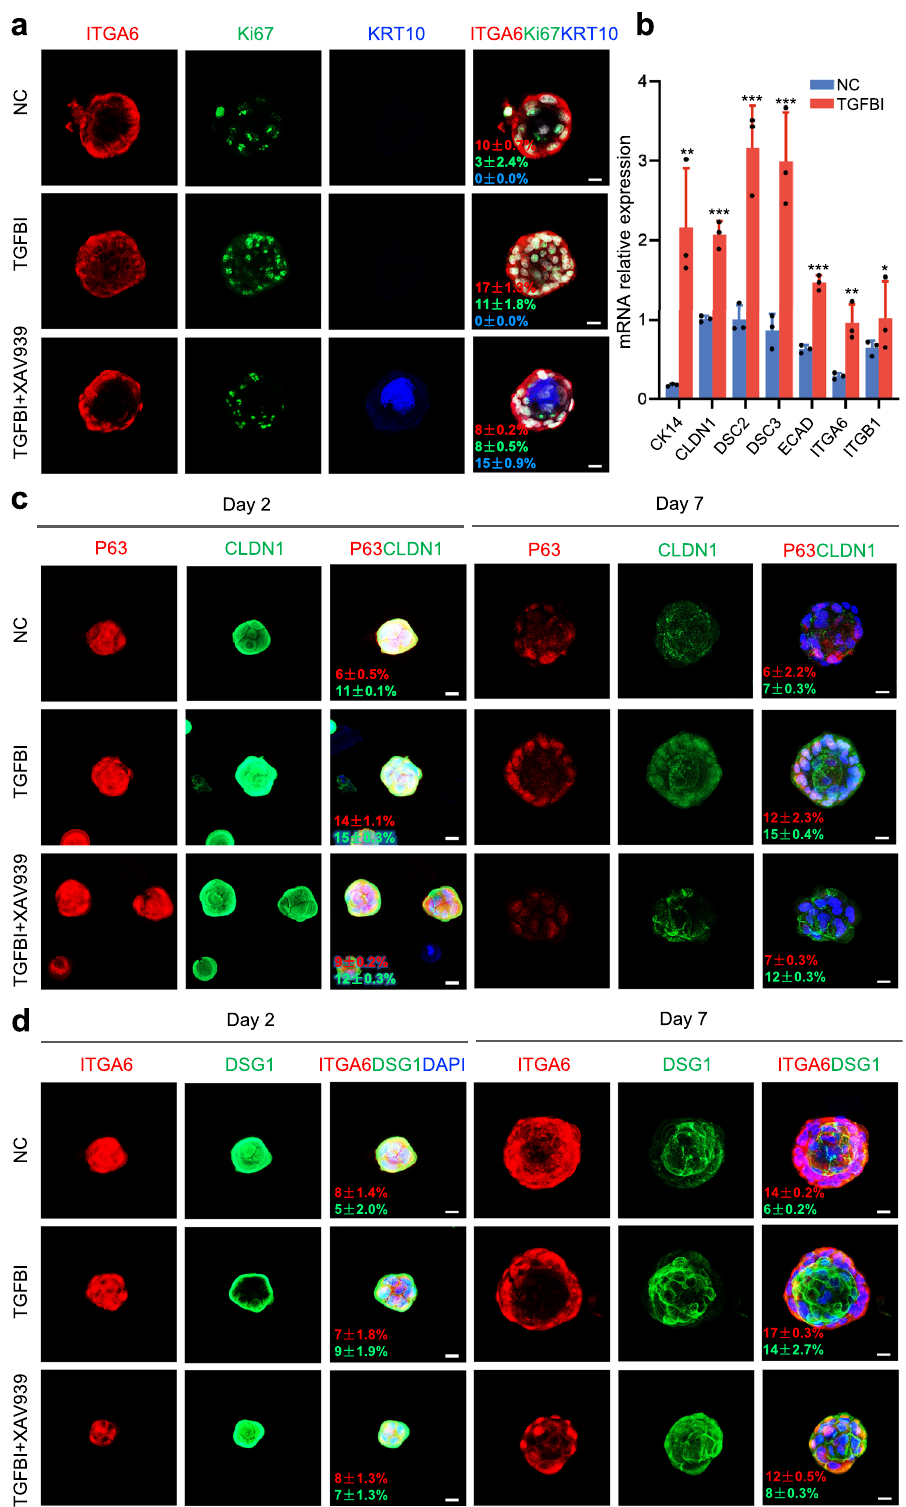
Fig. 5 TGFBI enhanced epidermal organoid development. a Immuno fl uorescence of ITGA6, Ki67, and KRT10 in epidermal organoids treated with TGFBI and XAV939 for seven days of culture (scale bar: 20 μ m). The experiment was repeated three times. b Relative expression of EpSC marker and adhesion junction genes after TGFBI treatment. The data are shown as the mean ± SD ( n = 3 per group). Signi fi cant differences between the TGFBI and control groups were determined by a two-tailed t test (* p < 0.05, ** p < 0.01, and *** p < 0.001). Immuno fl uorescence of P63 and CLDN1 ( c ) and ITGA6 and DSG1 ( d ) in epidermal organoids treated with TGFBI and XAV939 for two and seven days of culture (scale bar: 20 μ m). The experiment was repeated three times. Source data are provided as a Source Data fi